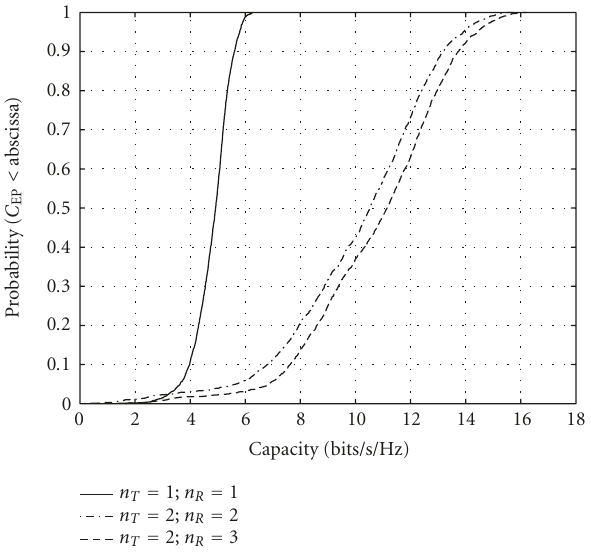
Figure 13: CDF of the received power (Scenario